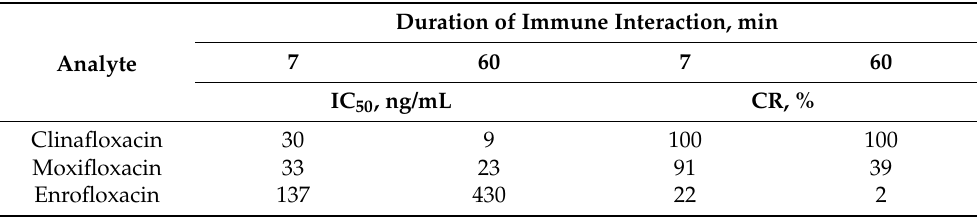
Table 5. IC 50 values of experimental calibration curves and cross-reactivities for the competitive assay of fluoroquinolones at varied durations of immune